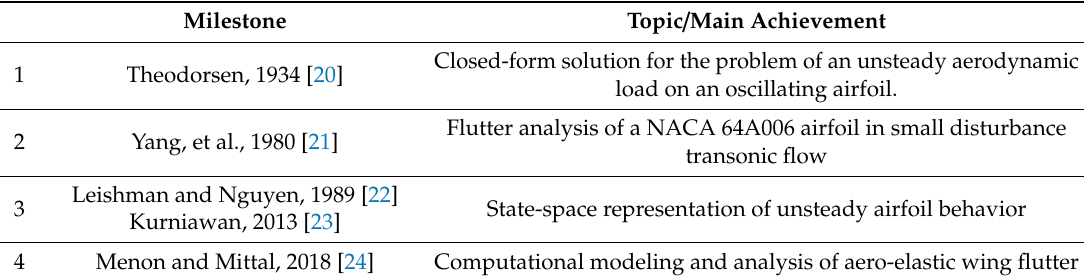
Table 1. Research milestones in airfoil aero-elastic behavior